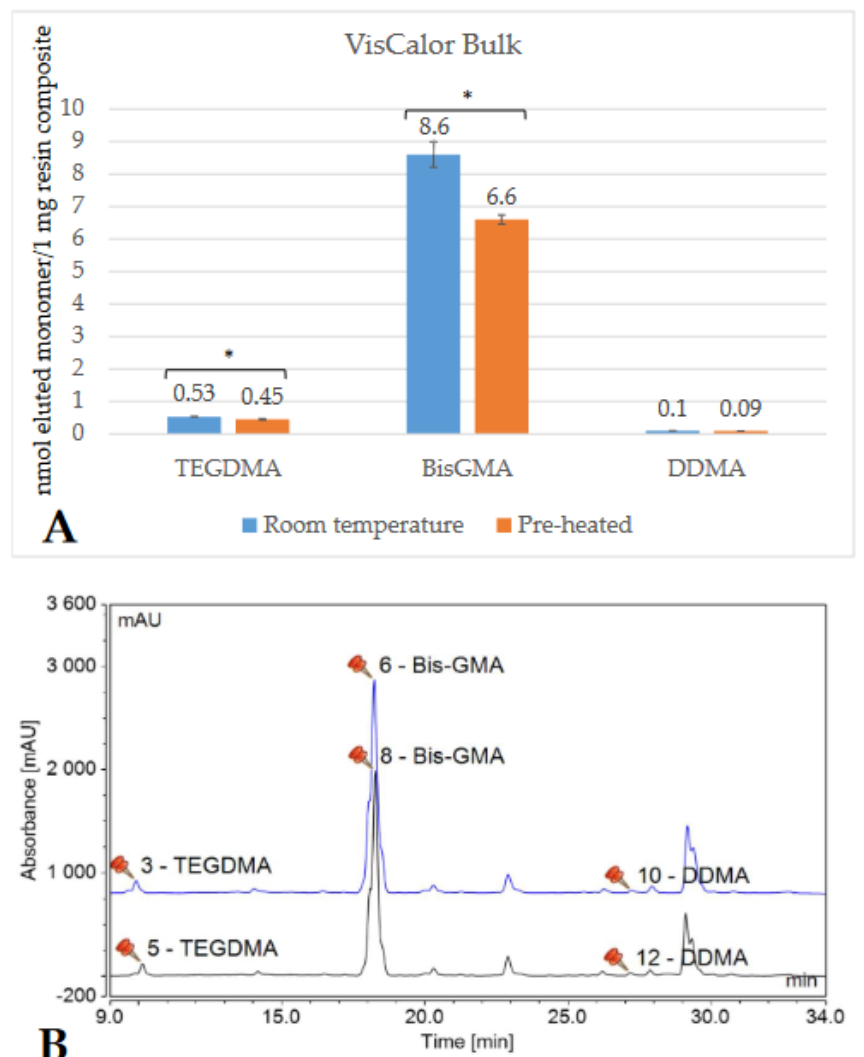
Figure 3. Comparison ( A ) of the amount of eluted monomers from room-temperature (blue bars) and pre-heated (orange bars) VisCalor Bulk samples. The * mark indicates statistically significant differences between the groups according to the independent two-tailed t -tests. The chromatogram ( B ) shows the detected monomers eluting from room-temperature (black chromatogram) and pre-heated (blue chromatogram) VisCalor Bulk and their retention time based on the standard monomers, evaluated at a 205 nm wavelength. (Abbreviations: BisGMA, bisphenol A-glycidyl methacrylate; TEGDMA, trietylene-glycol-dimethacrylate; DDMA, 1,12-dodecanediol-dimethacrylate; mAU, milli-Absorbance Units).